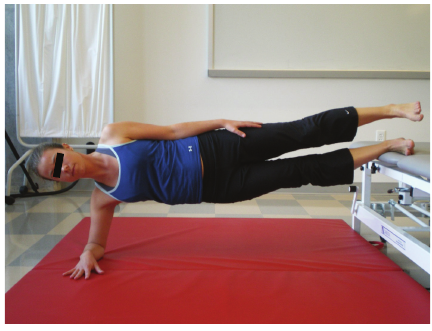
Figure 2: Lateral stabilizing line